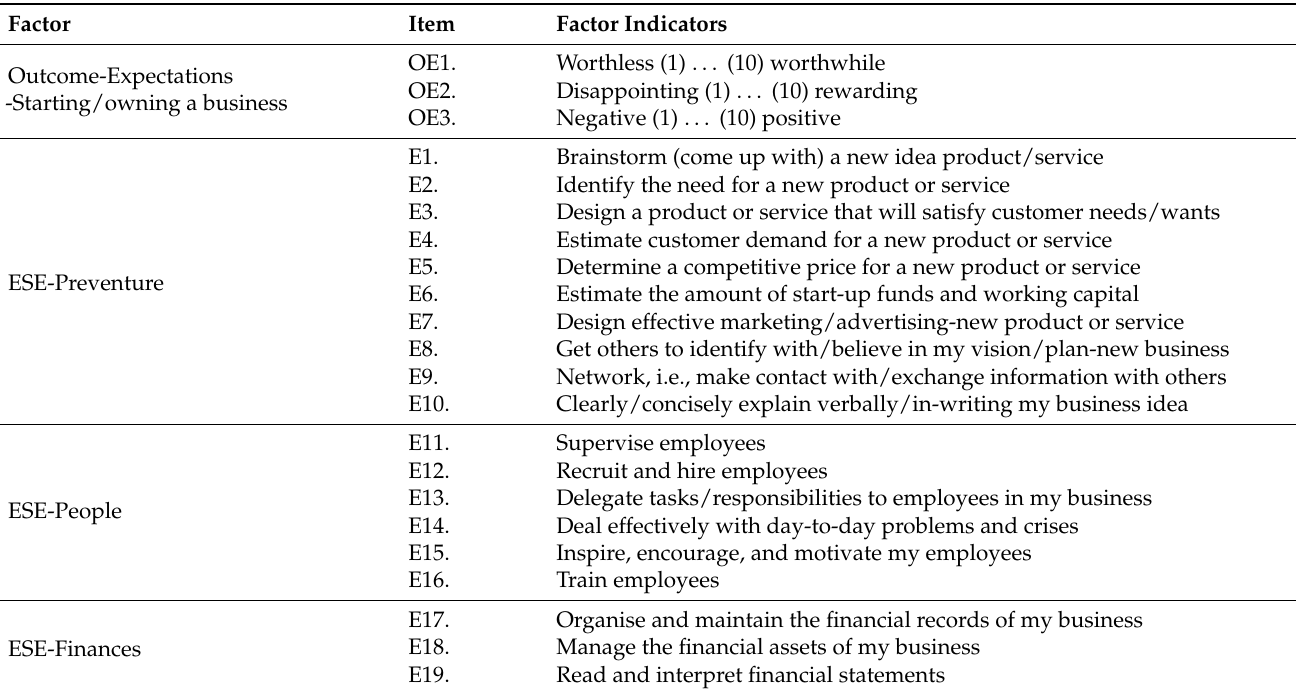
Table 2. Indicators used to form factor scores for ESE-pre-venture, ESE-people, and ESE-financial subscales and the unidimensional scale for business outcome expectations